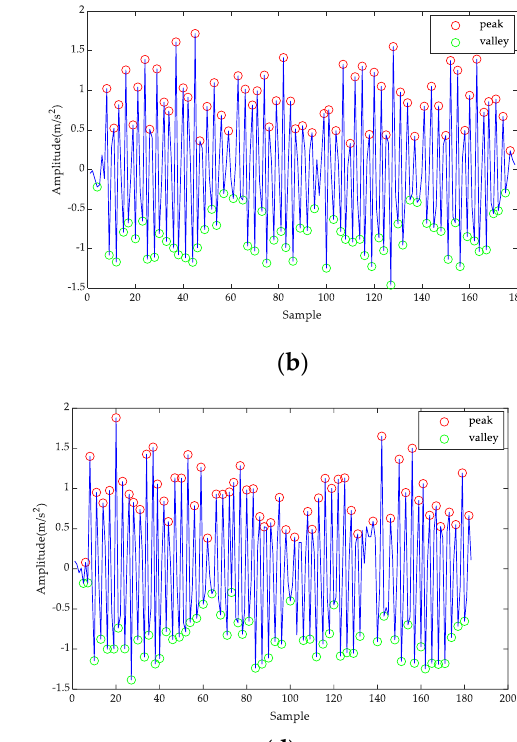
( d ) Figure 7. Peak and valley detection results with Honor60, VivoY85a, and two different height pe-